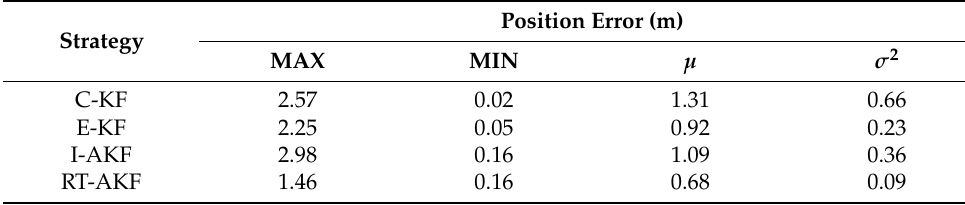
Table 6. Position Error Comparison Using Different Algorithm in Segment #4.